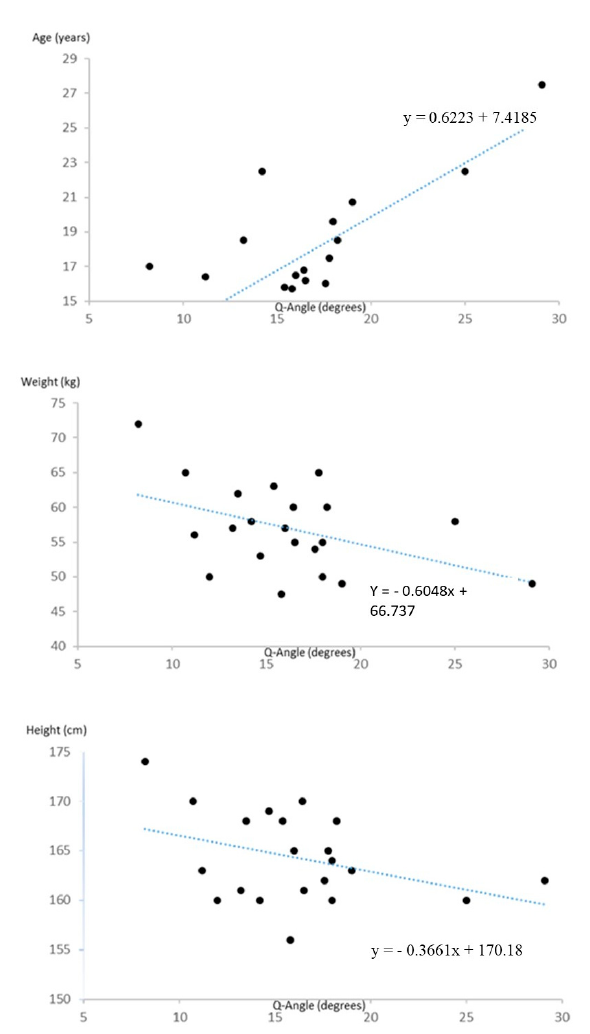
Figure 1. Relationship of Q-angle with age, weight, and height. No significant differences were found between the painful and asymptomatic subjects in all measured variables. Among all players, six subjects reported a pain score of 6 or above (28.5% of the sample), which is the threshold score in the SNAPPS questionnaire for knee pain. This percent is close to what was found in a previous study on young, female, non-sporting Chinese people (21.2%) [25]. Pain scores were not correlated with any measured variables in a previous study on non-sporting Chinese females [23], according to experts’ consensus [51], or in other populations [52]. Here, no significant differences were found between the left and right Q-angles. In our sample, the Q-angle values were above the means found in the literature for similar populations (Table 1). We did not find any correlation between Q-angle with jumps and elasticity index, perceived fatigue, and match time. Height was not correlated with match time. Performances by CMJ and SJ significantly decreased after a match. SJ performance decreased by 11.3% (t = 2.363, p = 0.028, Cohen’s D = 0.24) and CMJ performance decreased by 4.7% (t = 3.333, p = 0.003, Cohen’s D = 0.33) after a 44-min match (mean), though the elasticity index did not significantly change after such a match. The after-match Borg CR-10 score (Figure 2) was found to be 5 ± 3 (strong effort) and was highly correlated with playing time (r = 853, p = 0.000). No predictor